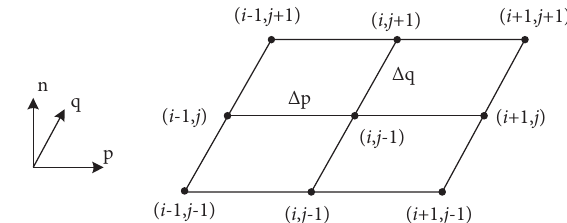
Figure 3: A quasi-rectangular unit formed by four grid elements for applying second-order finite-difference scheme.